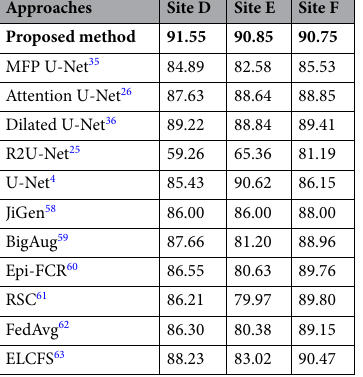
Table 5. Comparison the Dice coefficients result of the proposed model with other U-Net models as well as state-of-the-arts on multi-site MRI dataset separately. Significant values are given in bold.